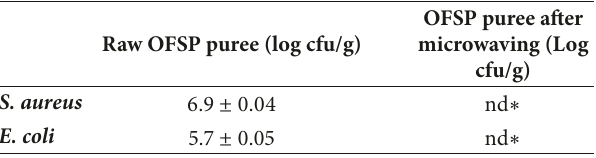
Table 1: Bacteria counts in OFSP puree (log cfu/g). Raw OFSP puree (log